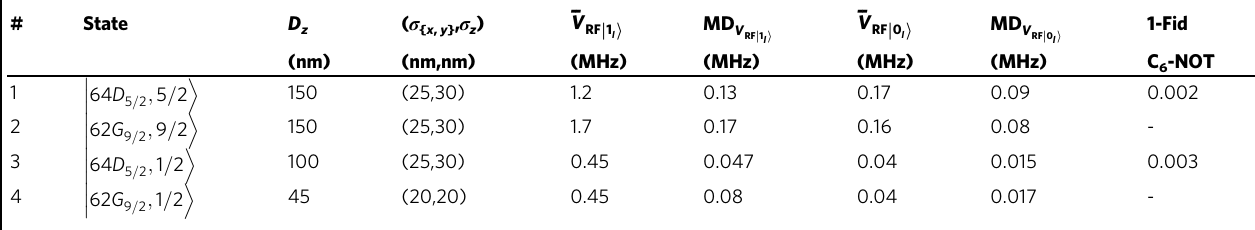
The wavelength of the in-plain optical-Lattice in #1,3 is λ = 795nm and in #2,4 is λ = 780nm 121 . In calculating the fi delity, spontaneous emission of nD state at 300K environment temperature is considered 89